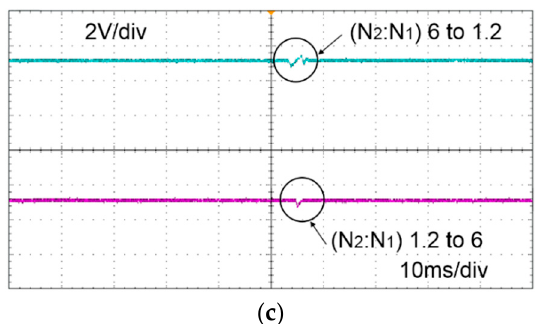
Figure 11. ( a ) The output voltage under the alteration of input current. ( b ) The output voltage under the alteration of the load. ( c ) The output voltage under the adjusting of the turn ratio.